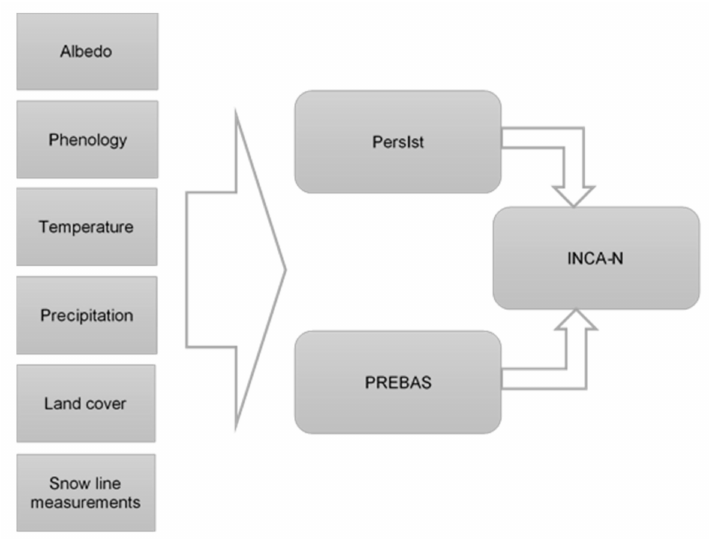
Figure 3. Flow chart of data and combination of models.